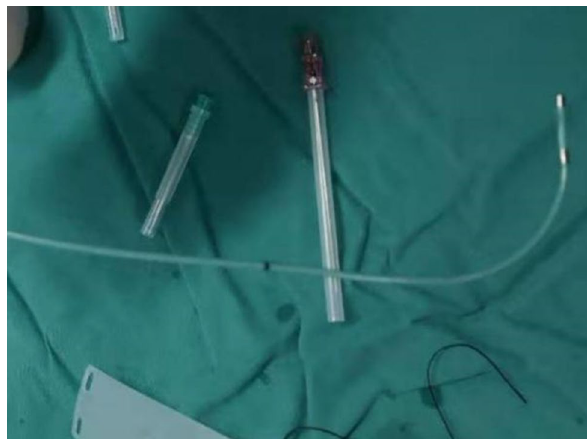
Figure 1. The bipolar electrode shaped as a quarter